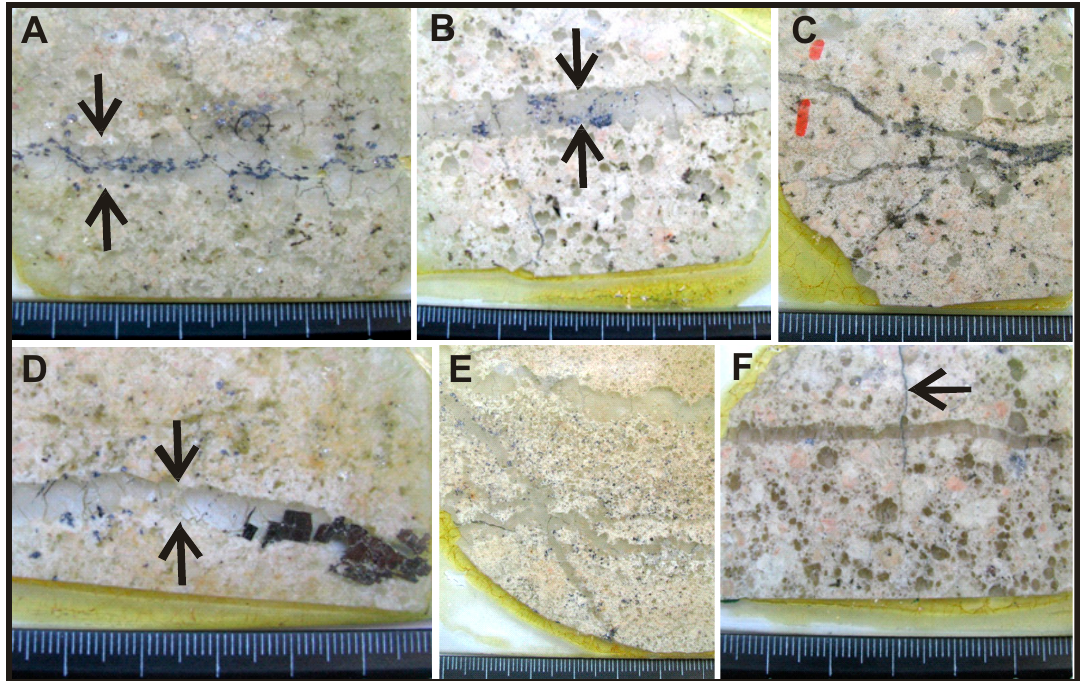
Figure 5. Quartz-molybdenite veinlets of type 1 ( A , B , C ) and molybdenite-poor veinlets of type 2 ( D , E , F ). The arrow in Fig. F indicates a narrow “dry” molybdenite veinlet. The arrows in other figures show the width of veins.